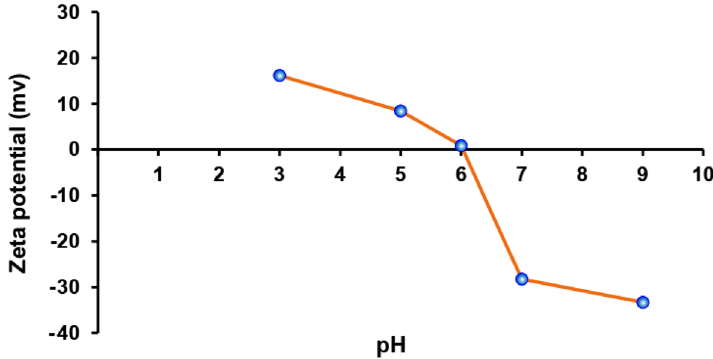
Figure 12. The zeta potential of Fe 3 O 4 @SiO 2 @TAD-G3 at different